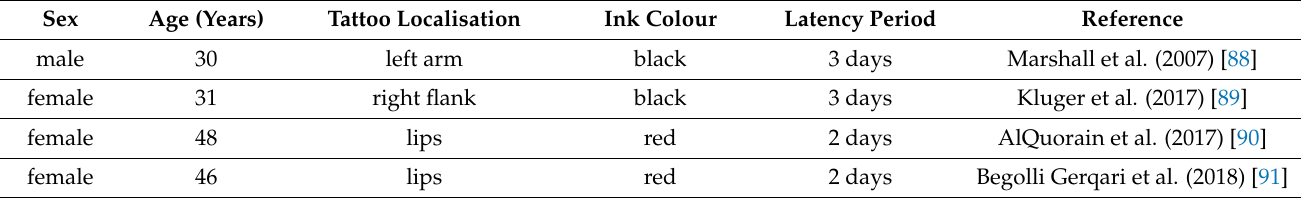
Table 3. Epidemiological and clinical characteristics of the reported cases of herpes simplex on tattoos.